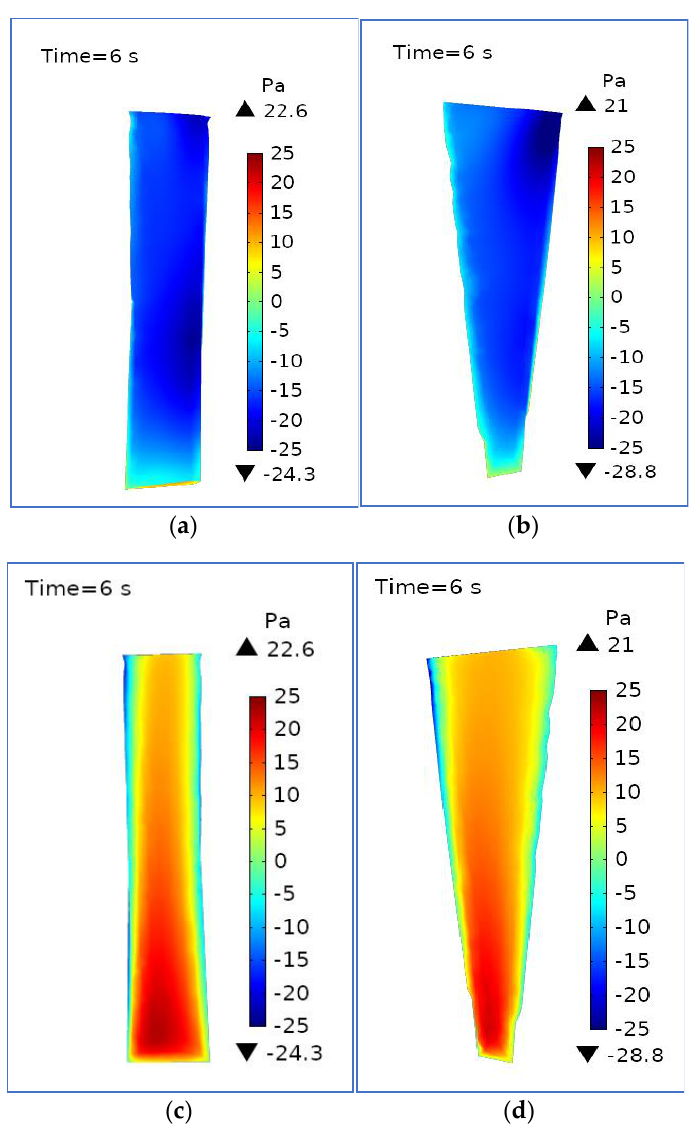
Figure 12. Negative suction pressure and positive pressure distributions for ( a , c ) rectangular blades and ( b , d ) tapered blade configurations.